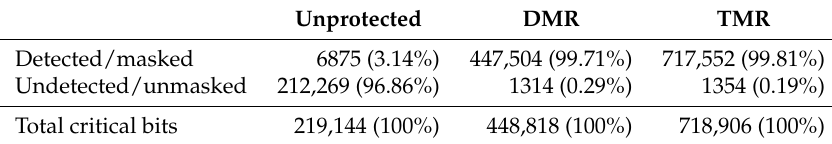
Table 6. Reliability results for the different unprotected and protected architectures (synthetic image).